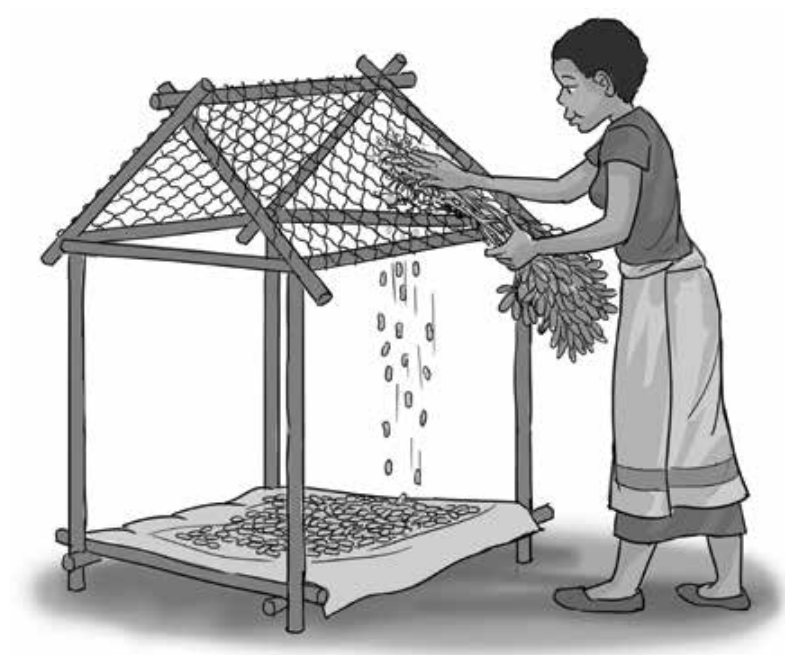
Figure 8: Simple pod stripper in use Due to shortage of labour, some smallholder farmers store their groundnut crops on the plant indoors until they have time to strip the pods and dry them. This is not advisable, as the groundnut will be exposed to aflatoxin